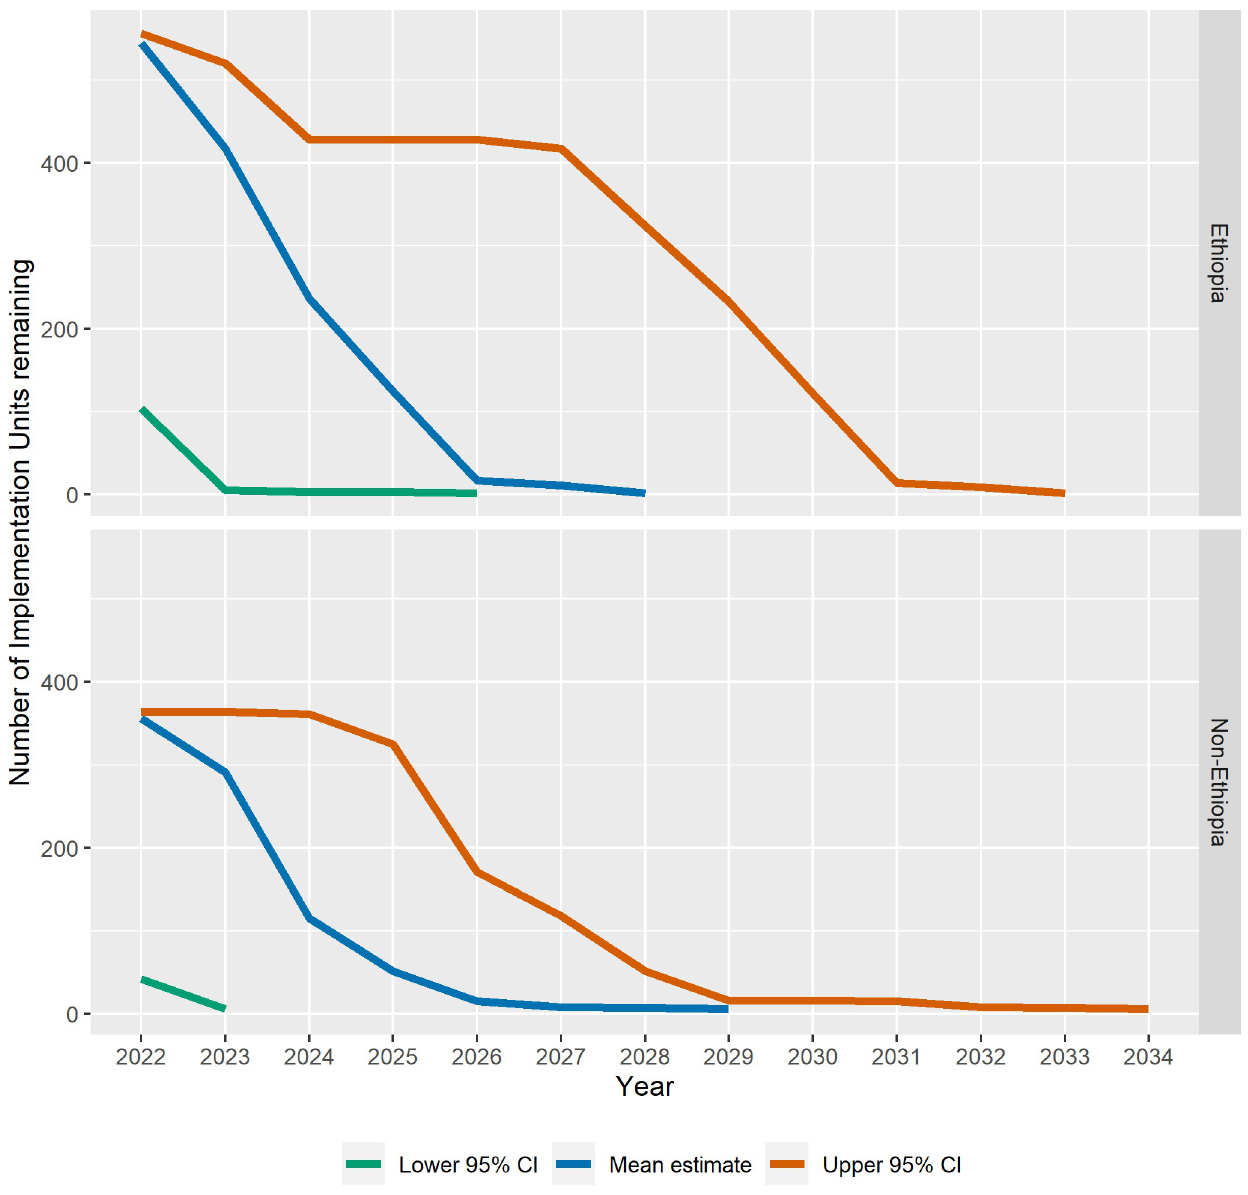
Fig 2. Mean, lower 95% CI, and upper 95% CI forecast number of Implementation Units remaining requiring Mass Drug Administration by year, Ethiopia vs.